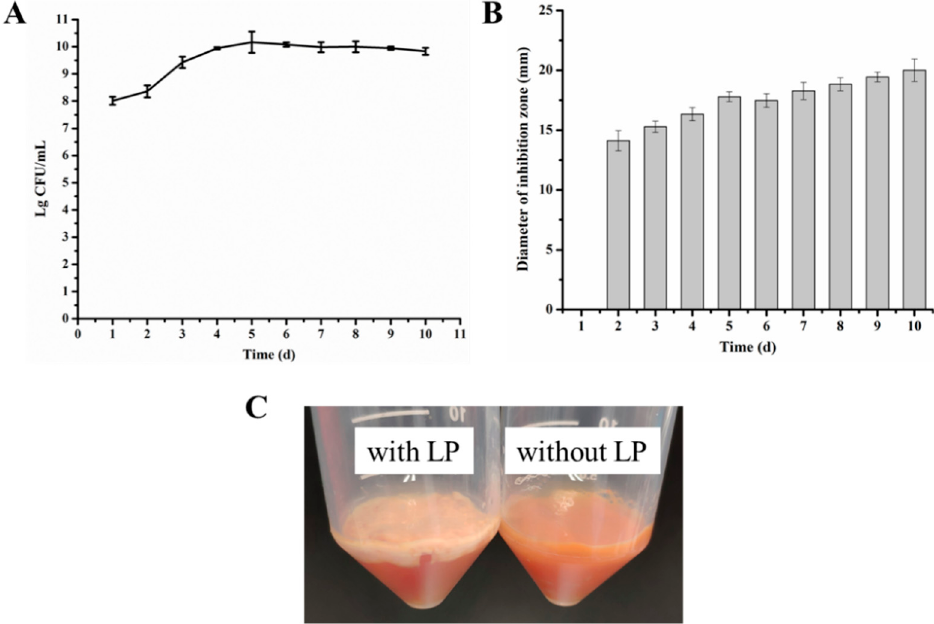
Figure 2. Fermentation characteristics of tomato juice by L. paracasei WX322. ( A ), Microbial number of L. paracasei WX322; ( B ), antibacterial activity of fermentation supernatant; ( C ), residues of fer- mented tomato juice after centrifugation, LP is L. paracasei WX322.